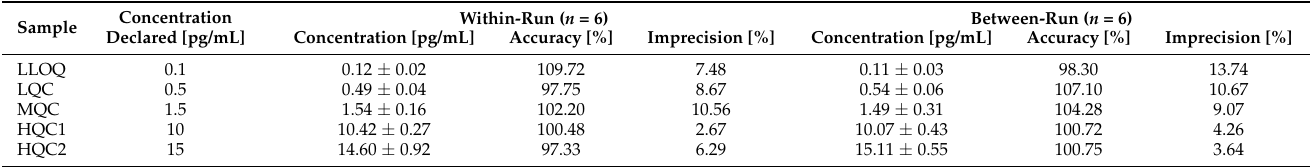
Table 1. Within-run and between-run accuracy and precision (n = 6).